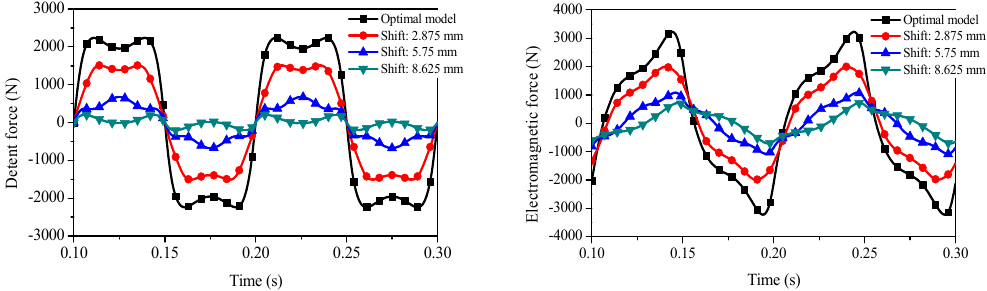
Figure 14. Detent and electromagnetic force for different shifting lengths.